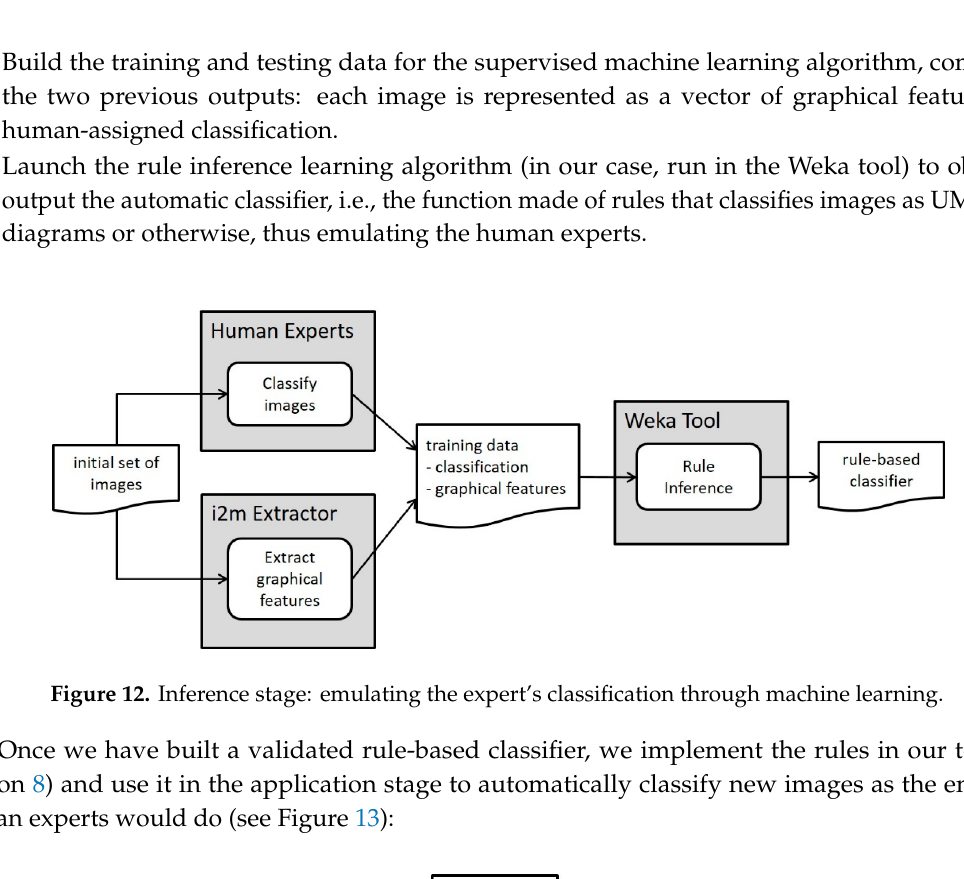
Figure 12. Inference stage: emulating the expert’s classification through machine learning